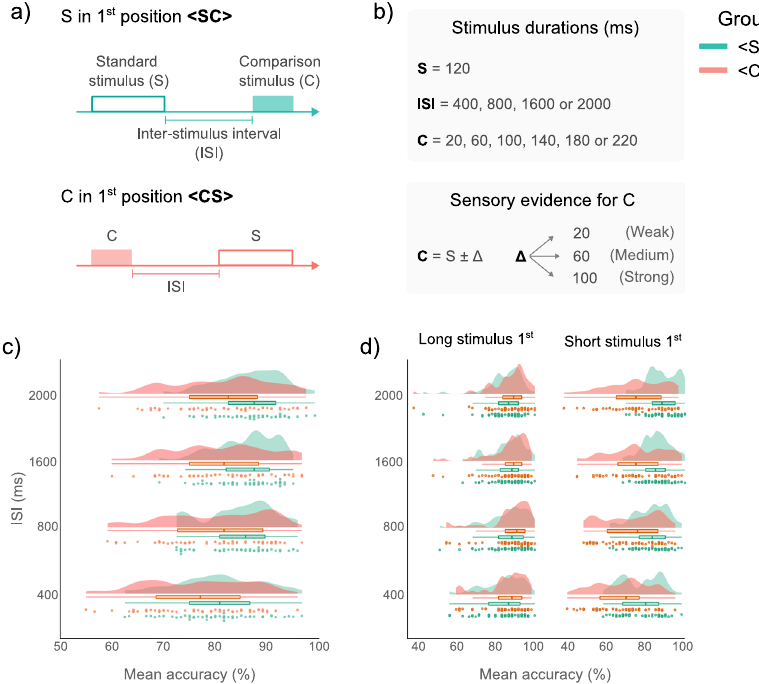
Figure 1. Two-interval forced choice (2IFC) task and accuracy. ( a ) Timeline of events in the 2IFC task. For the <SC> group the standard stimulus (S) was displayed in the 1st position and in the 2nd position for the <CS> group. ( b ) The S stimulus had a fixed duration of 120 ms, whereas the comparison stimulus ( c ) varied trial-by-trial according to its level of sensory evidence: weak, medium, or strong. We implemented four Inter- stimulus intervals (ISIs: 400, 800, 1600 and 2000 ms). ( c ) Mean accuracy for each group and each ISI level. Data points depict the mean accuracy for each participant. Box and density plots show the distribution of the mean accuracy for both <SC> and <CS> groups. The median is represented by the vertical line in the box plots, whereas the right and left edges depict the interquartile range (IQR). Accuracy is higher for the <SC> group, however for both groups the accuracy increased for ISI > 400 ms. ( d ) Mean accuracy separated by the ordinal position of the longer stimulus. Accuracy for the <CS> group decreases when the 1st stimulus is shorter than the 2nd stimulus.